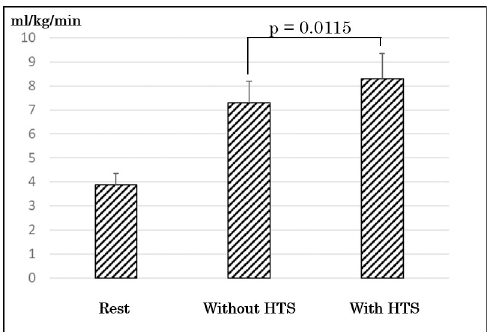
Fig 3. Comparing of changes of oxygen uptake. HTS, hybrid training